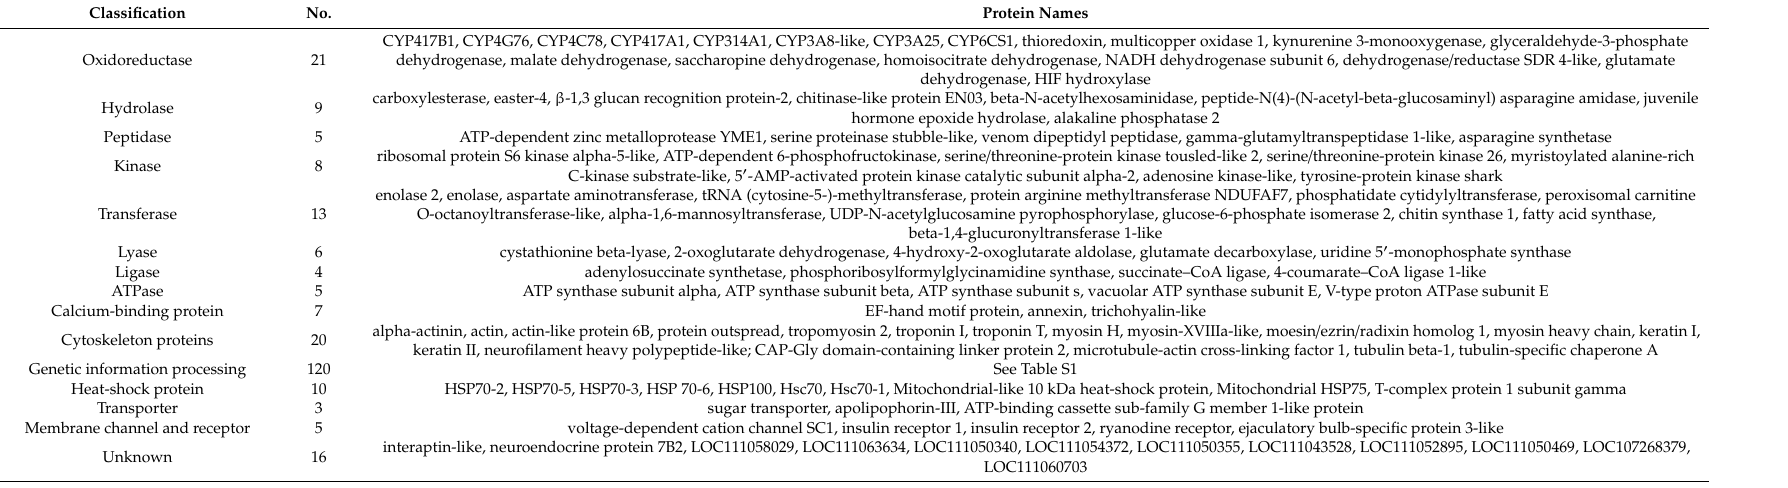
Table 1. Identified proteins from the brown planthopper (BPH) honeydew against the BPH protein databases (matched peptides > 1). Classification